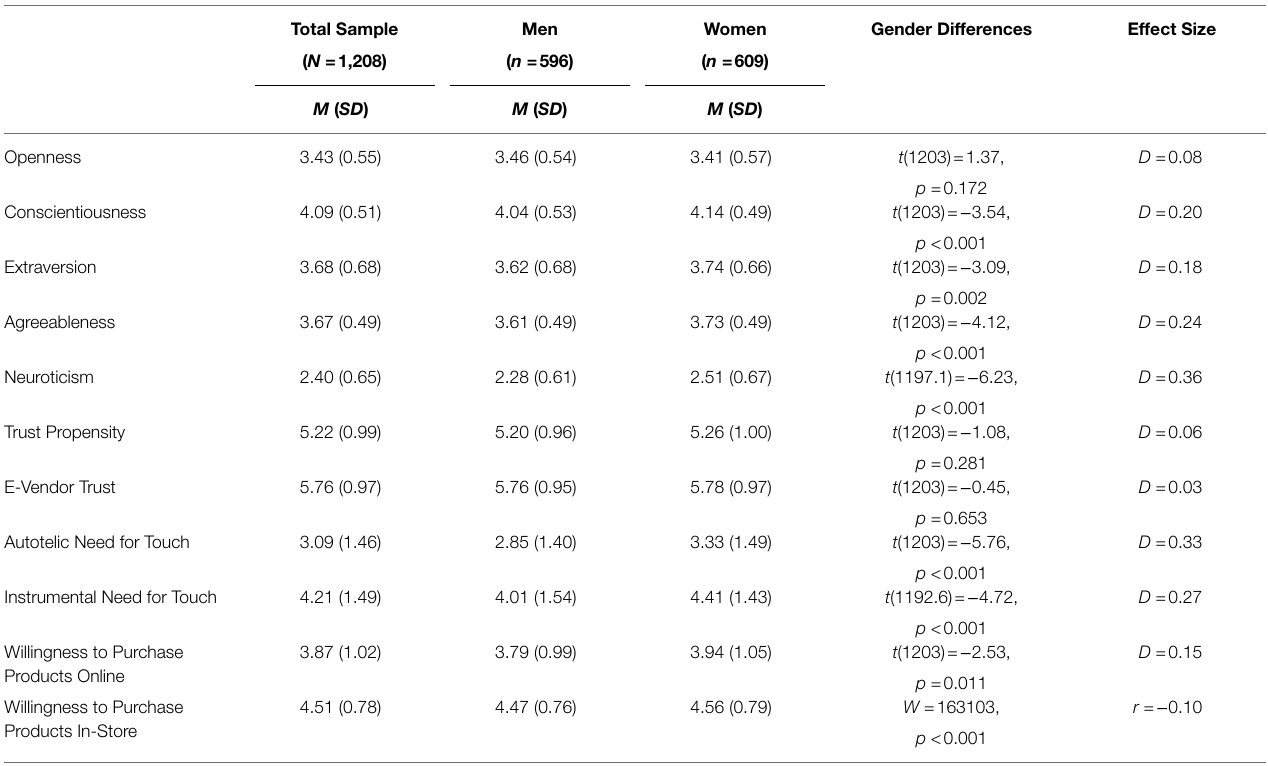
TABLE A1 | Descriptive statistics and gender